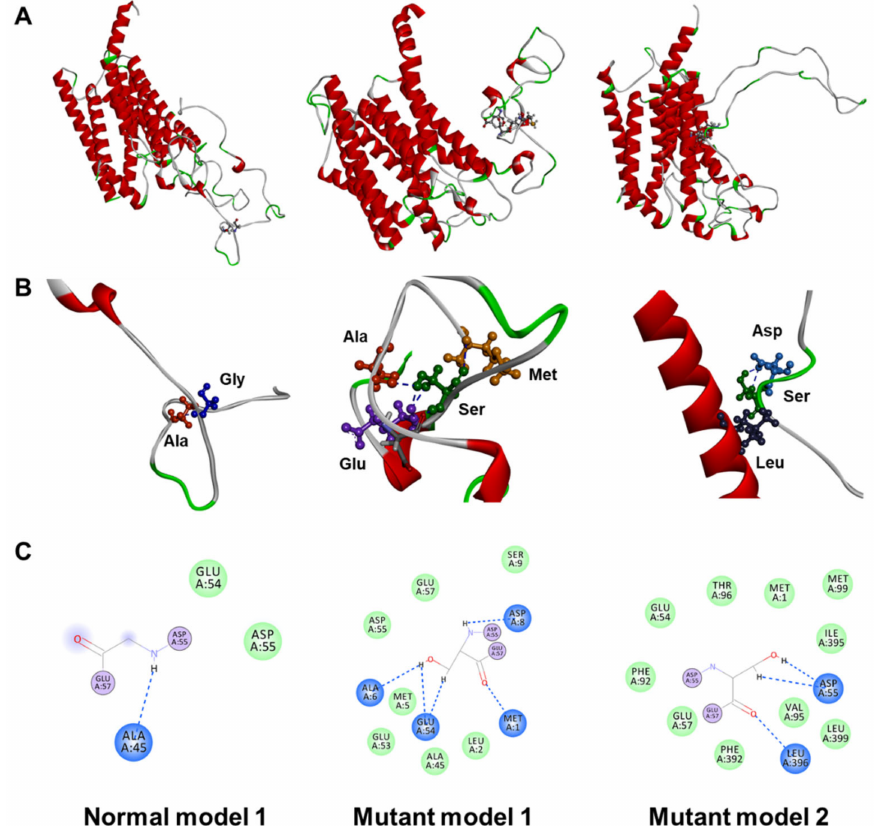
Figure 3. Three-dimensional predicted structure and possible intramolecular interactions of PS2 Gly56Ser. ( A ) Predicted 3D structures of the wild-type and mutant PS2 proteins. ( B ) Enlarged images of specific interaction areas and ( C ) 2D diagram of amino acid interactions. Blue indicates hydrogen bonds and green represents van der Waals